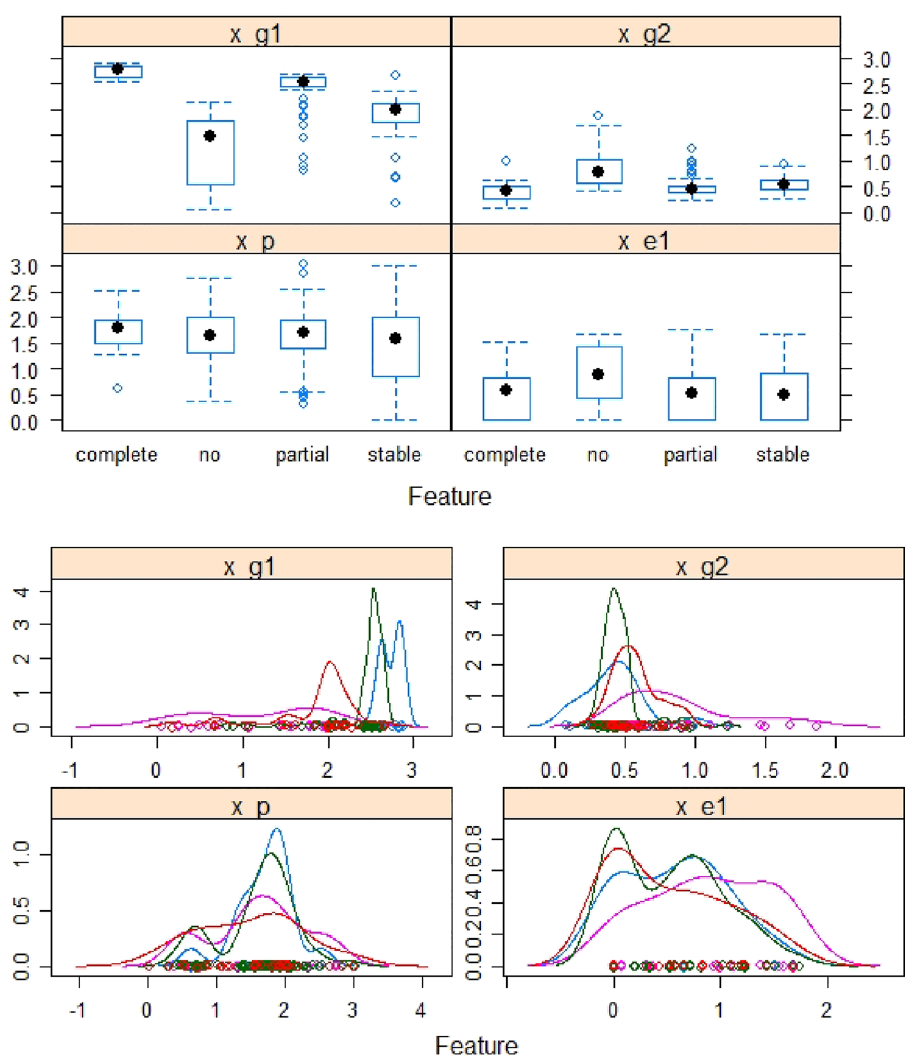
Figure 12. Geometric, energy and personal features and their